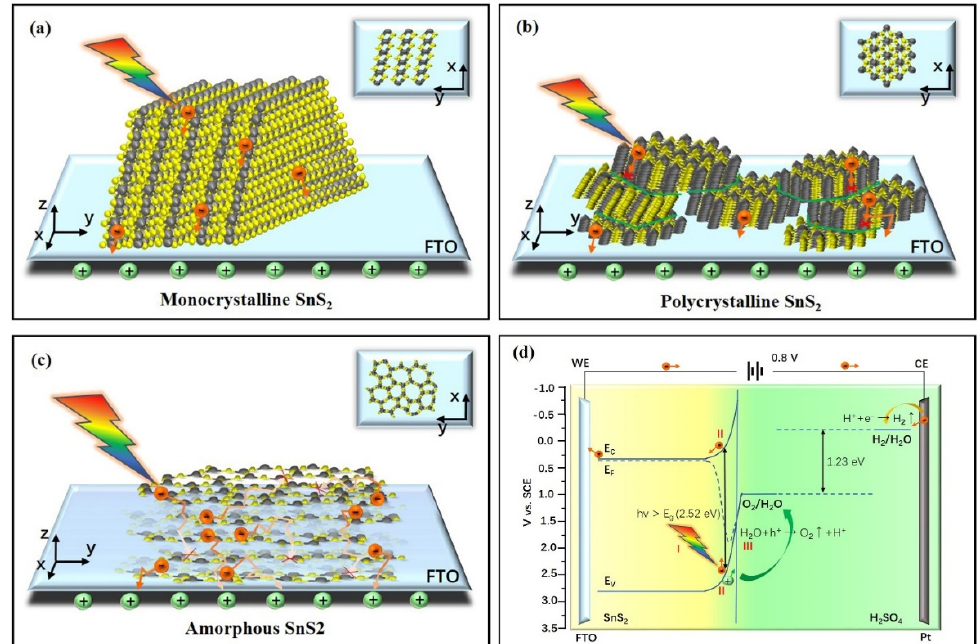
Figure 7. ( a – c ) Schematics demonstrating the efficient photon capture and charge transport from SnS 2 to the FTO electrode: ( a ) monocrystalline, ( b ) polycrystalline, and ( c ) amorphous SnS 2 . The gray spheres represent tin atoms, while the yellow spheres represent sulfur atoms. ( d ) Schematic of SnS 2 used in PEC water splitting. The main processes include ( Ⅰ ) light energy absorption, ( Ⅱ ) photoelectron–hole pair separation and transport, and ( Ⅲ ) surface redox reaction.